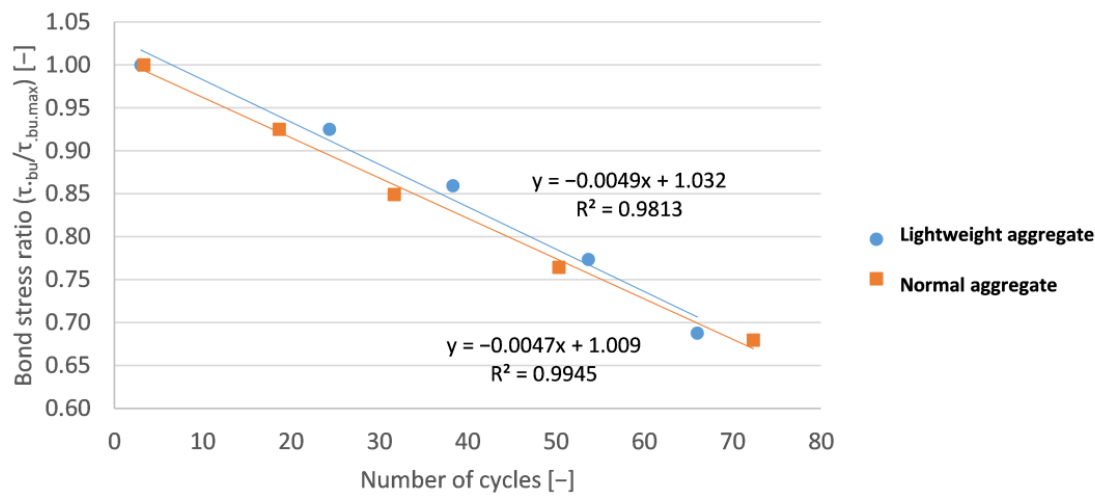
Figure 18. Fatigue curves belonging to the bond stress (R2: the coefficient of determination).